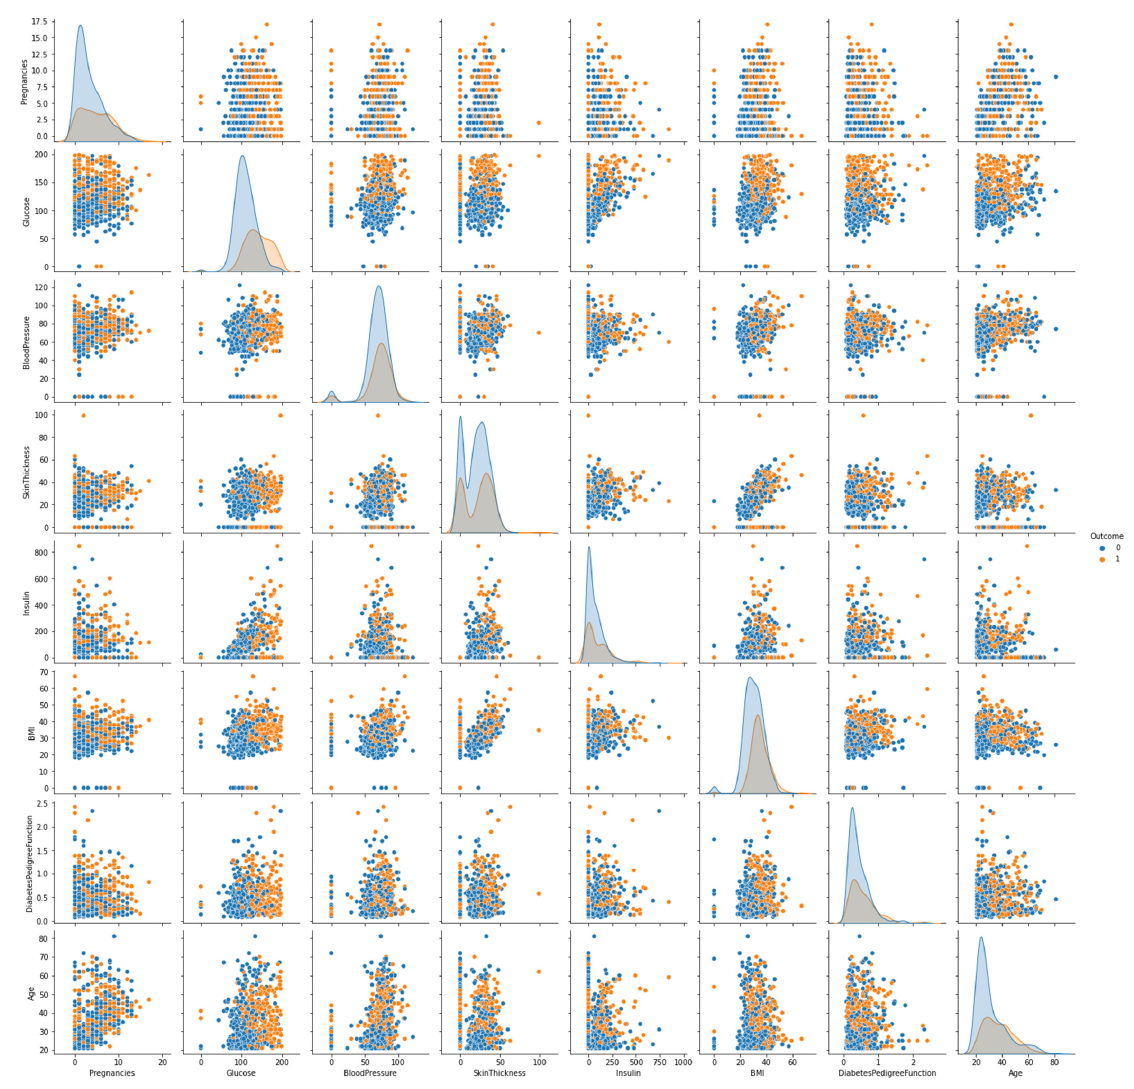
Figure 2. Visualization of all of the attributes present in the Pima Indian Diabetes dataset (outcome 0: non-diabetic and outcome 1: diabetic).